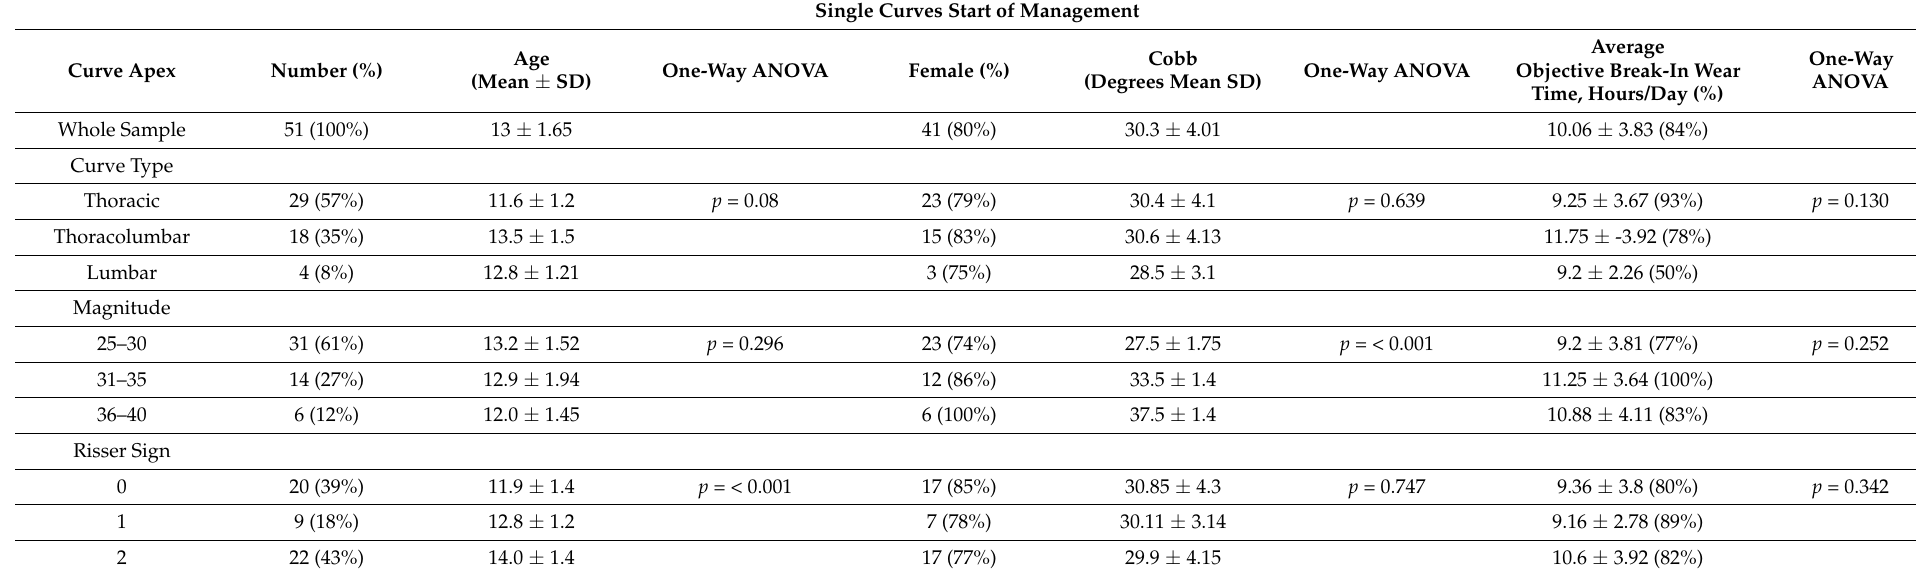
Table 1. Single-curve breakdown at the start of management.